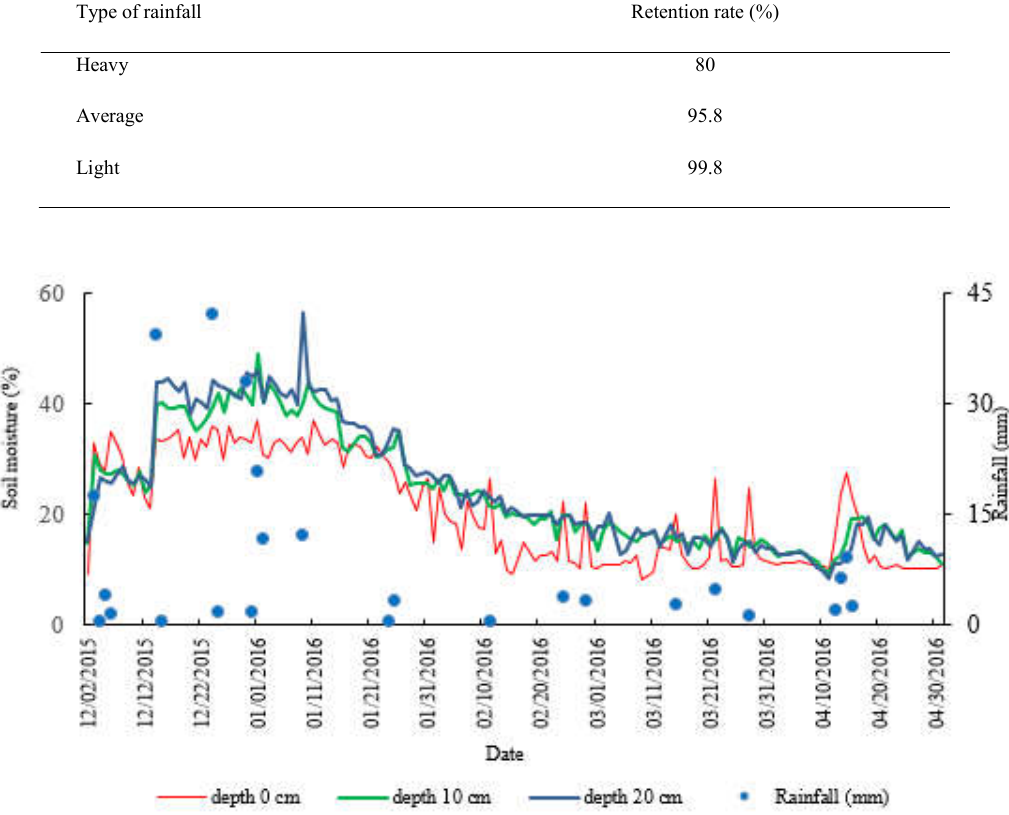
Fig. 7: Moisture changes in various depths and